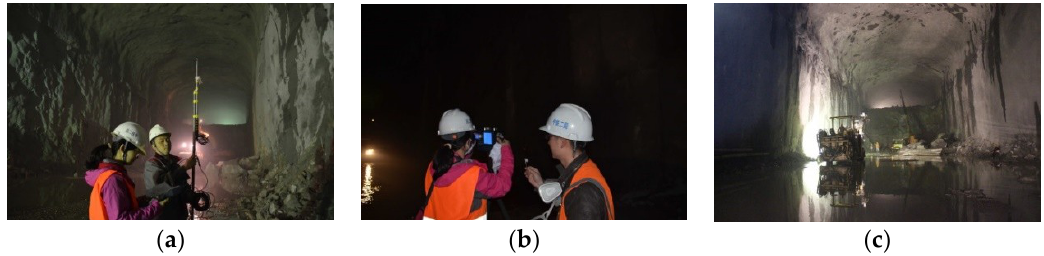
Figure 4. Field test of ventilation environment in the caverns: ( a ) Test of air velocity; ( b ) Test of dust; ( c ) Air quality after ventilation.